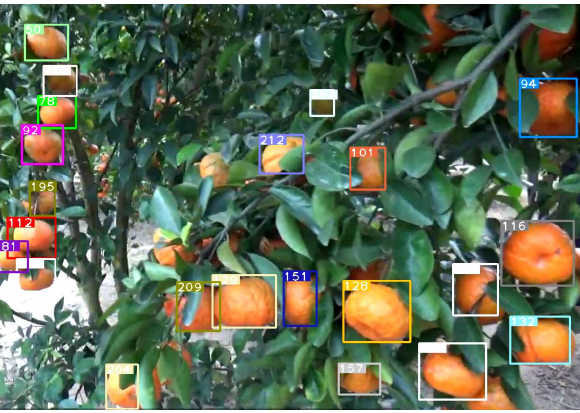
Figure 16. A view of detected oranges in the tree, numbers denote track